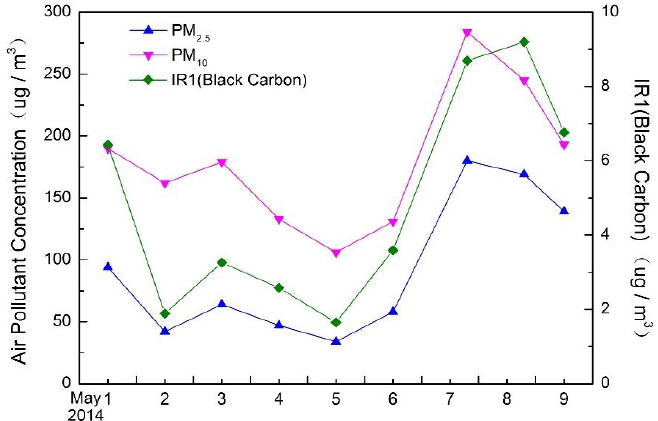
Figure 1. Daily concentration of pollutants in Chengdu between 1 May 2014 and 9 May 2014, extracted from ground-based monitoring data of an automatic air-monitoring substation in Sichuan Province (30.63°N, 104.07°E).